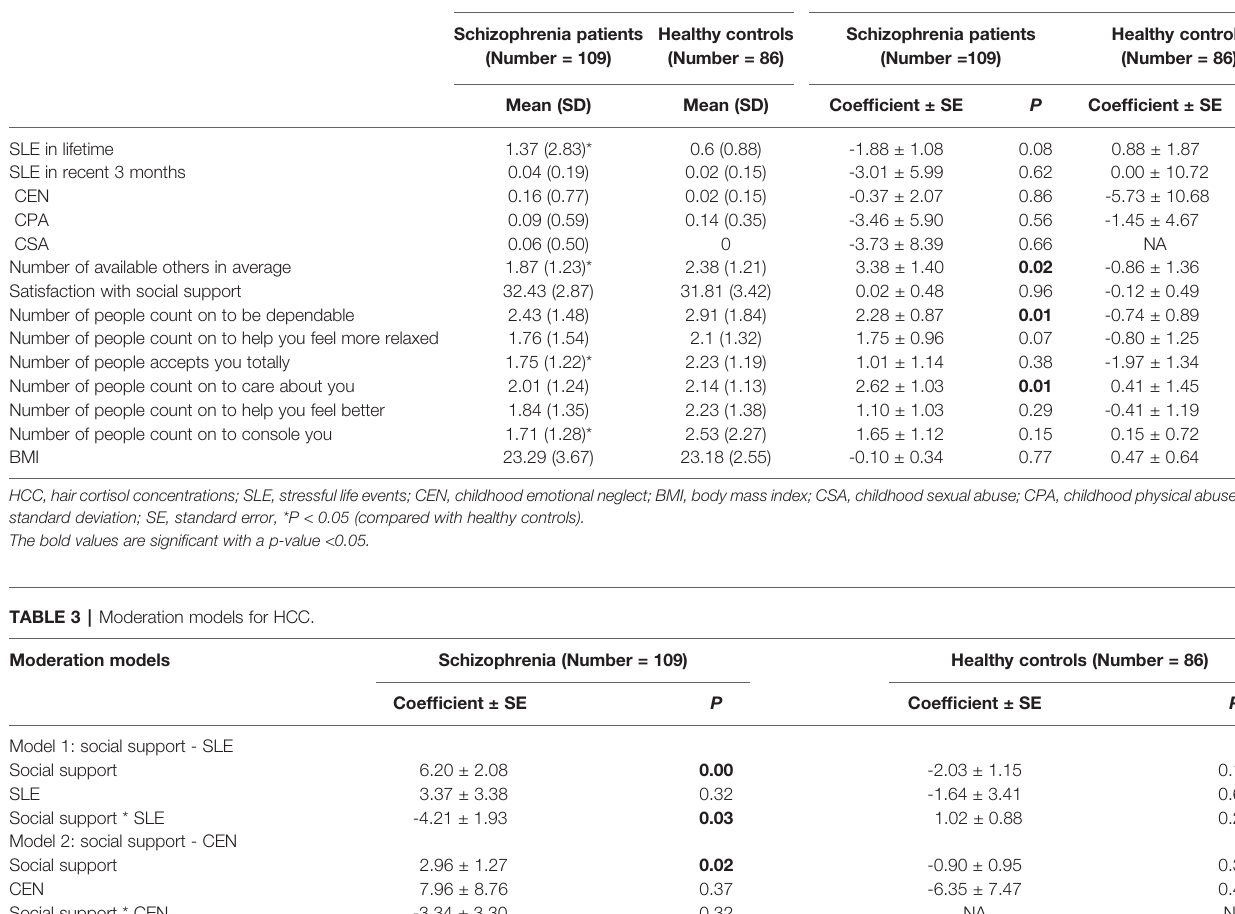
TABLE 2 | Comparison and association between variables and HCC. Variables Variables Association of HCC with variables